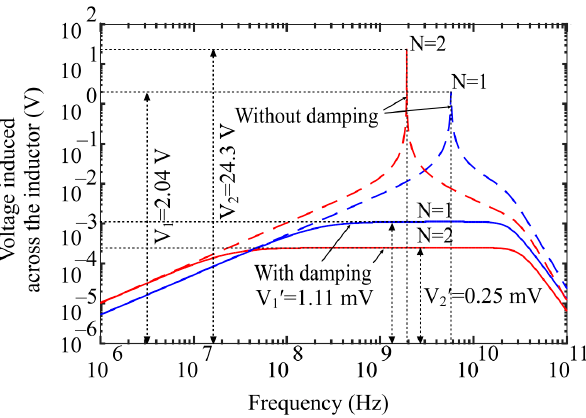
Figure 4. Frequency response of the loop inductor with and without a damping resistance.